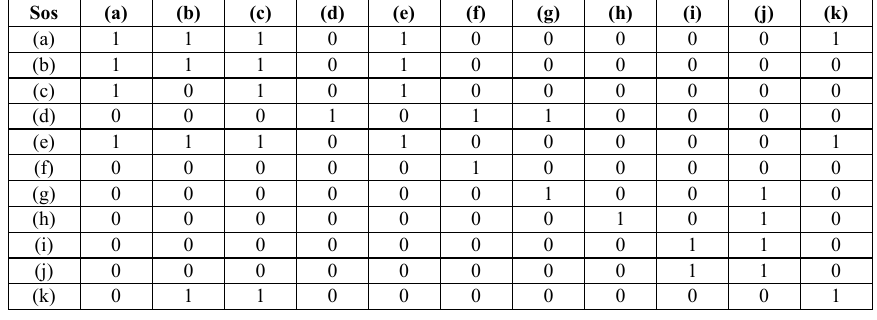
Table 4. The Initial Reachability Matrix of SOs